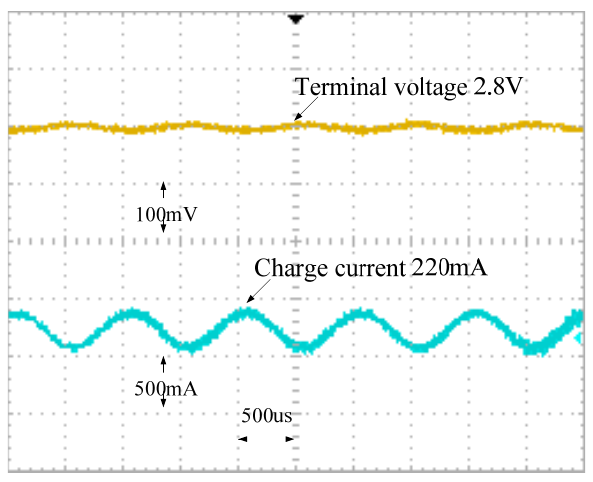
Figure 16. The measured charge current and terminal voltage waveforms at an SOC of 0%.